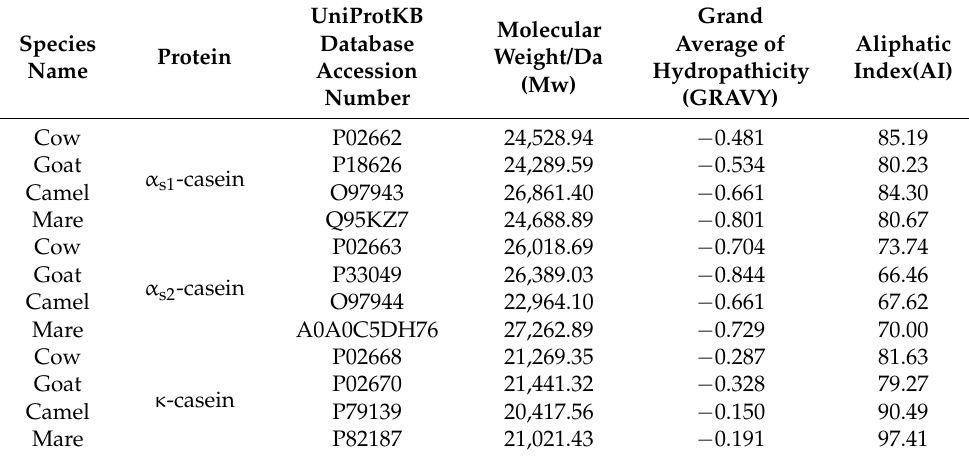
Table 2. Predicting results of the physicochemical properties of allergenic subtypes ( α S1 -CN, α S2 -CN, and κ -CN), respectively, in CM, GM, CAM, and MM, as well as their accession numbers in the UniProtKB